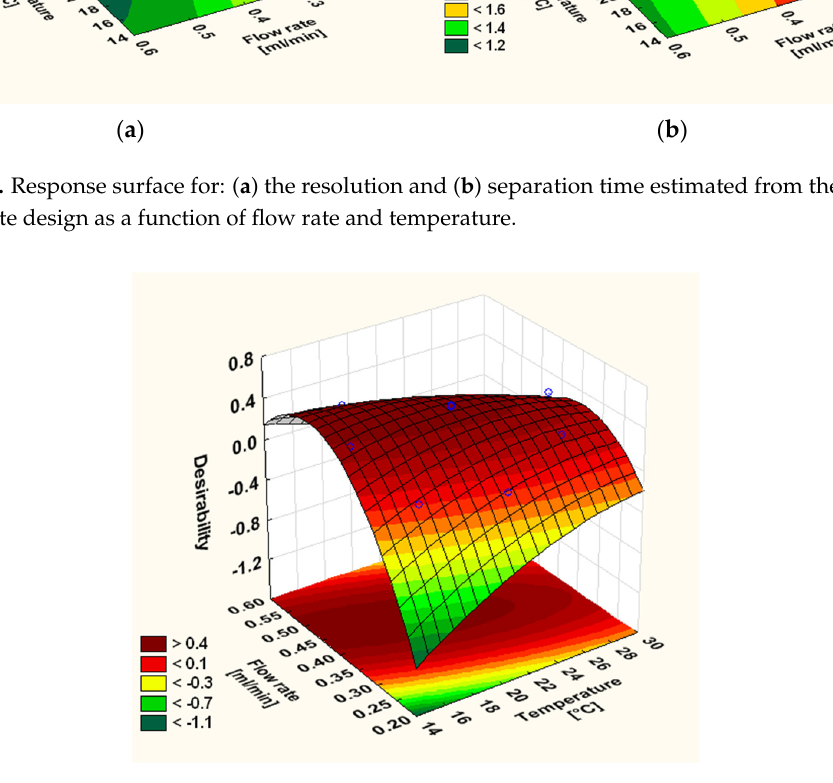
Table 3. Experimental and predicted responses under optimal conditions.